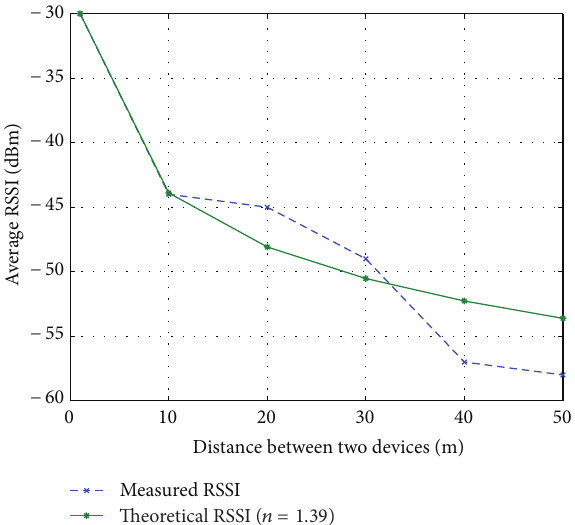
Figure 11: Measured RSSI (avg. of 1,000 samples) at various outdoor spots.